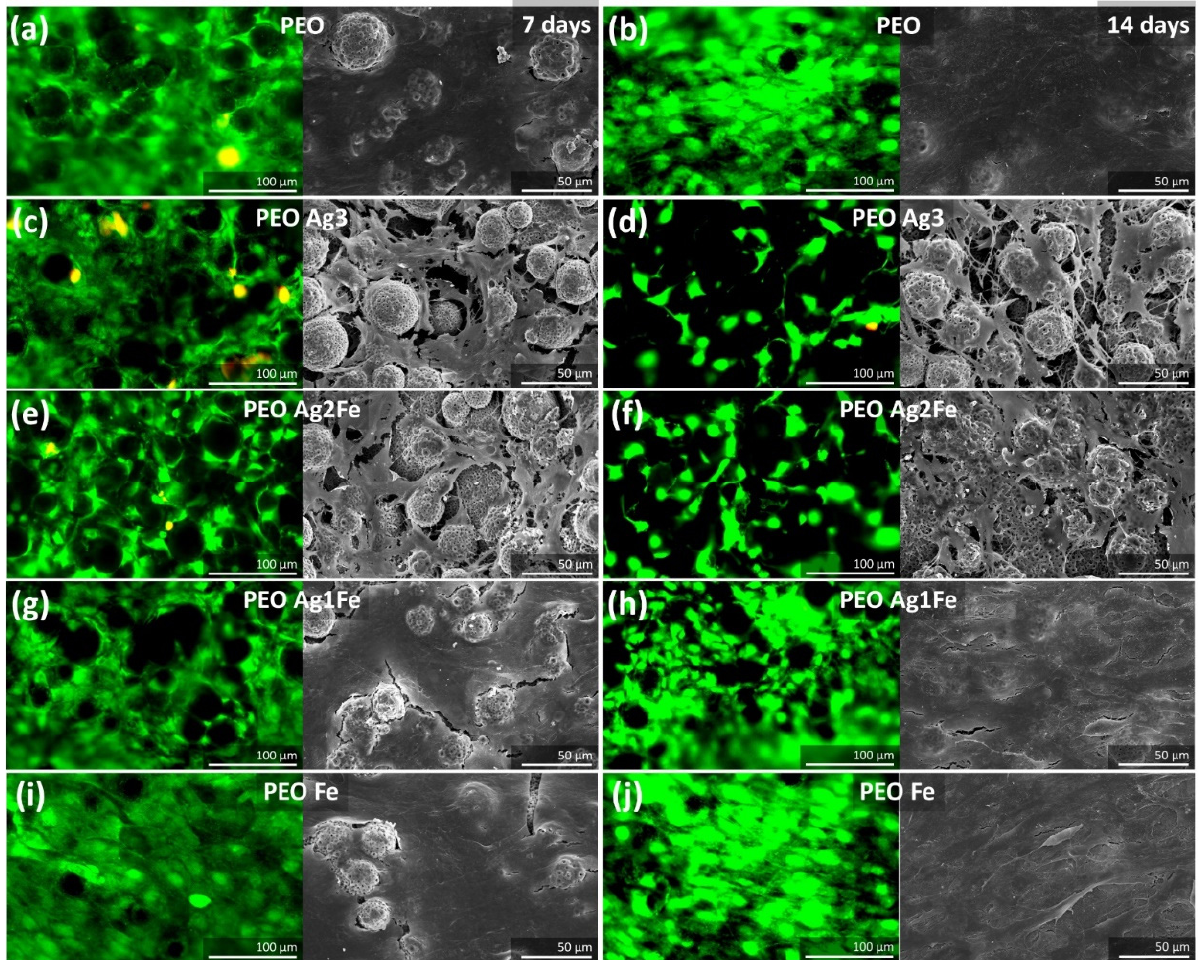
Figure 5. The cytocompatibility of the surface-biofunctionalized scaffolds towards preosteoblasts MC3T3-E1 under osteogenic conditions. The viability of cells was assessed by live/dead staining and the morphology of cells were imaged using SEM after culture for 7 and 14 days on the ( a , b ) PEO, ( c , d ) PEO Ag3, ( e , f ) PEO Ag2Fe, ( g , h ) PEO Ag1Fe, and ( i , j ) PEO Fe specimens.